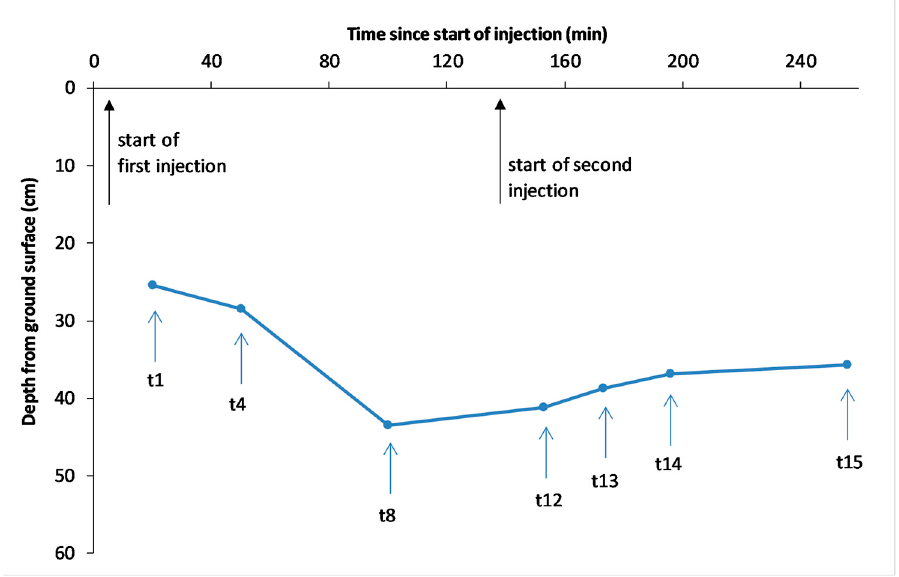
Figure 5. Depth of the mass center reached after two injections.